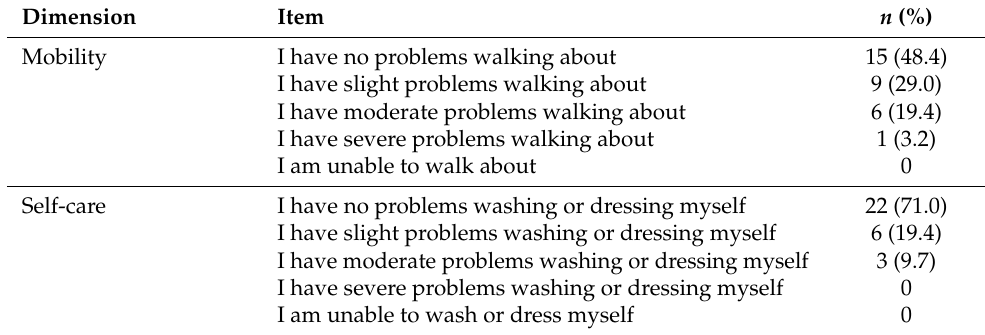
Table 2. Frequency and percentage of results of the EQ-5D-5L in each dimension.